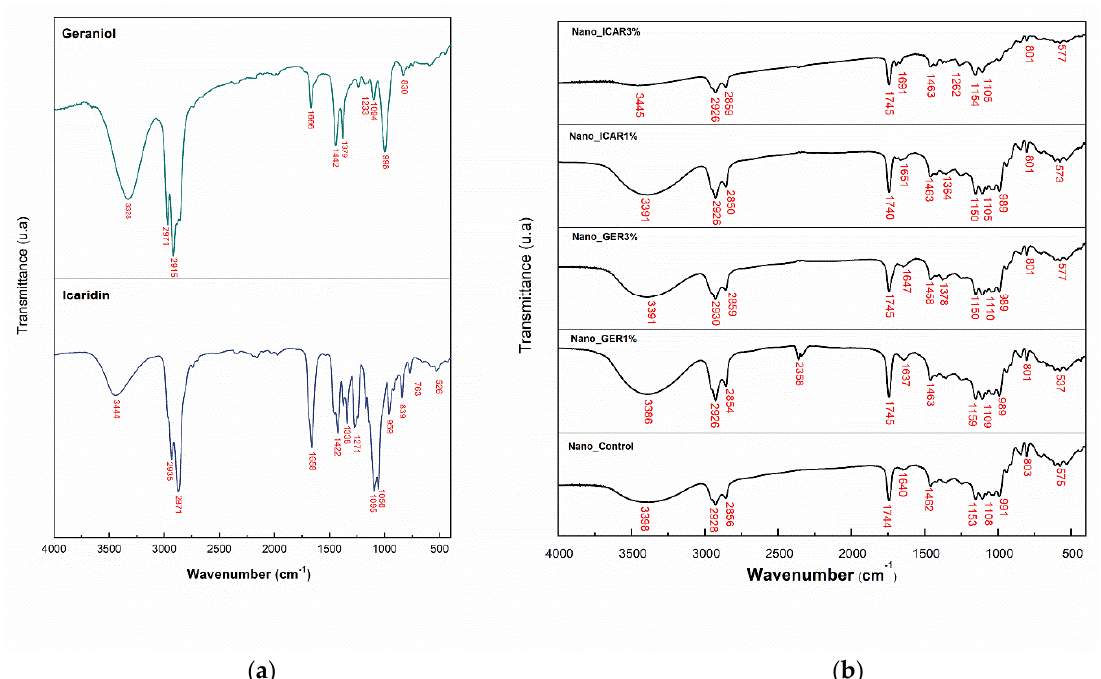
Figure 6. ( a ) Infrared spectra for the bioactives geraniol and icaridin and ( b ) infrared spectra for the formulations Nano_Control, Nano _GER1%, Nano_GER3%; Nano_ICAR1%, and Nano _ICAR3%. The spectra were obtained through Fourier transform infrared spectroscopy (FTIR) using KBr, in the frequency range from 4000 to 400 cm − 1